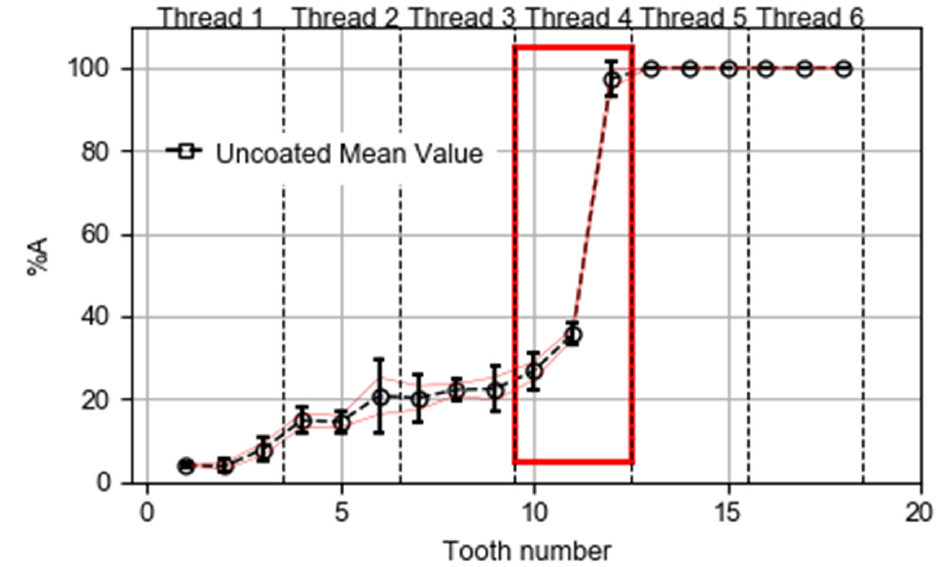
Figure 15. Evolution of average % A on the teeth of uncoated taps.